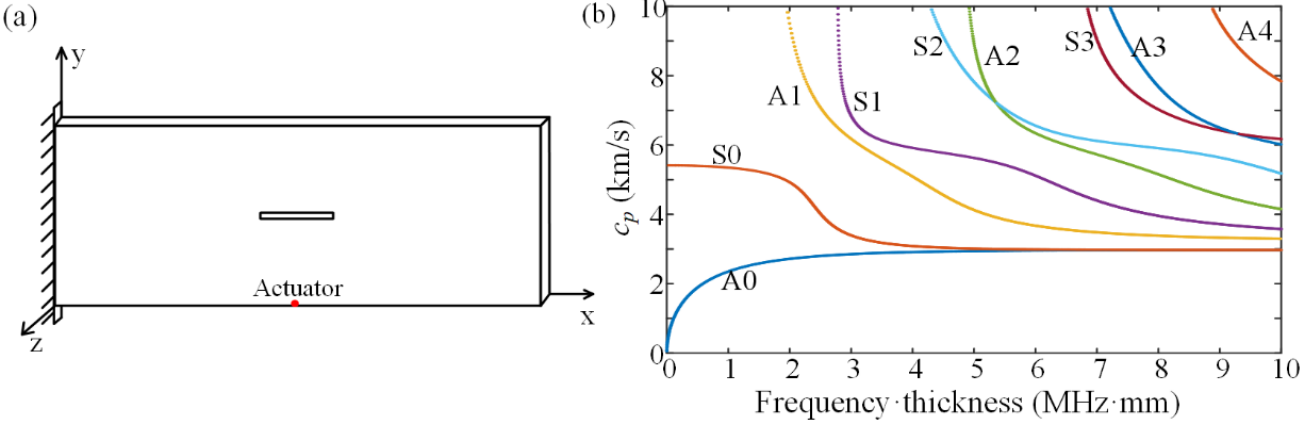
Figure 1. ( a ) Dimension of the damaged plate and the location of the actuator. ( b ) The dispersion curves.